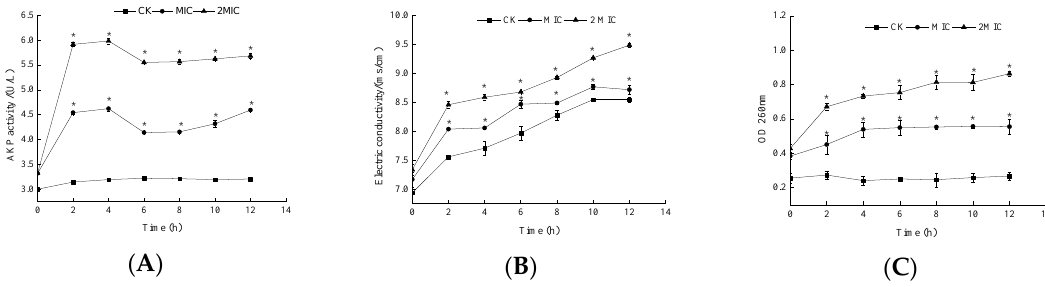
Figure 3. E ff ects of ε -PL on AKP ( A ), Electrical conductivity ( B ) and OD 260 nm ( C ) of S. putrefaciens. Bars represent the standard error of the means. The superscript (*) indicates a result that is significantly di ff erent to the equivalent control point ( t test, p <